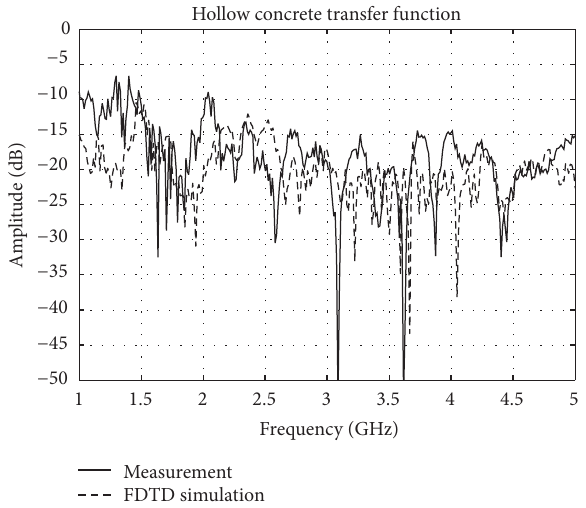
F5:Cinderblockswalltransferfunctionobtainedbymeasure- ment and by FDTD simulation.